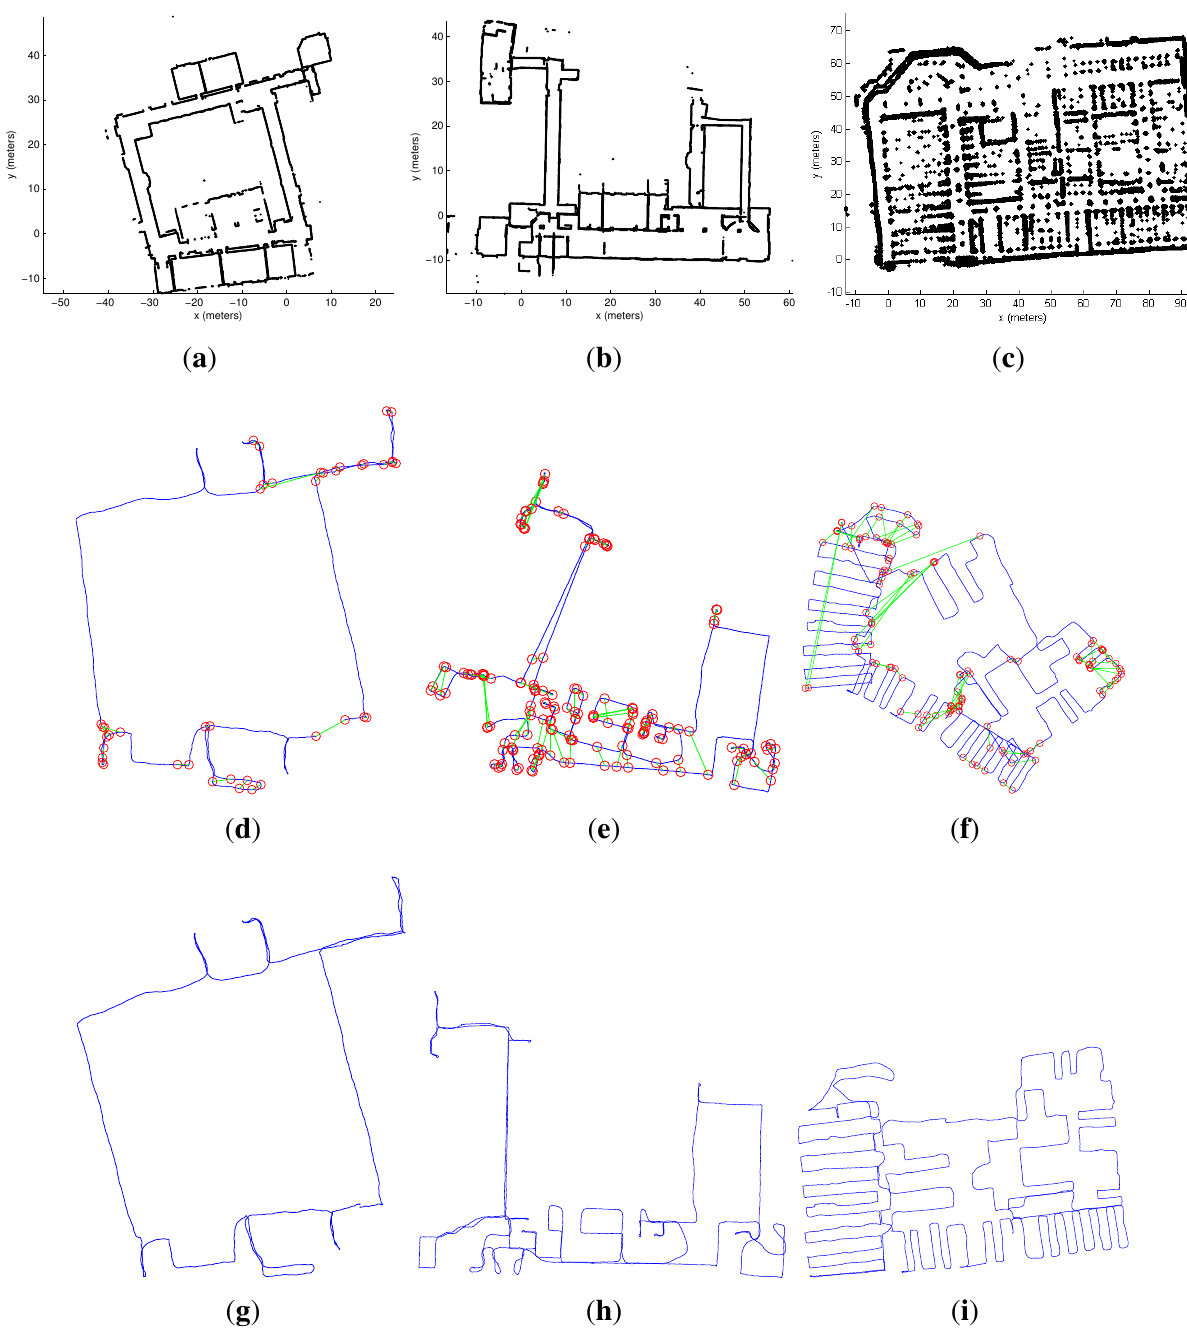
Figure 17. Results of applying the end-to-end system. ( a ), ( b ), ( c ) The occupancy grid maps that result from the RBPF algorithm. ( d ), ( e ), ( f ) The dead reckoning trajectories with validated loop closure constraints overlain. ( g ), ( h ), ( i ) The 3D paths viewed from the top down after optimization has been